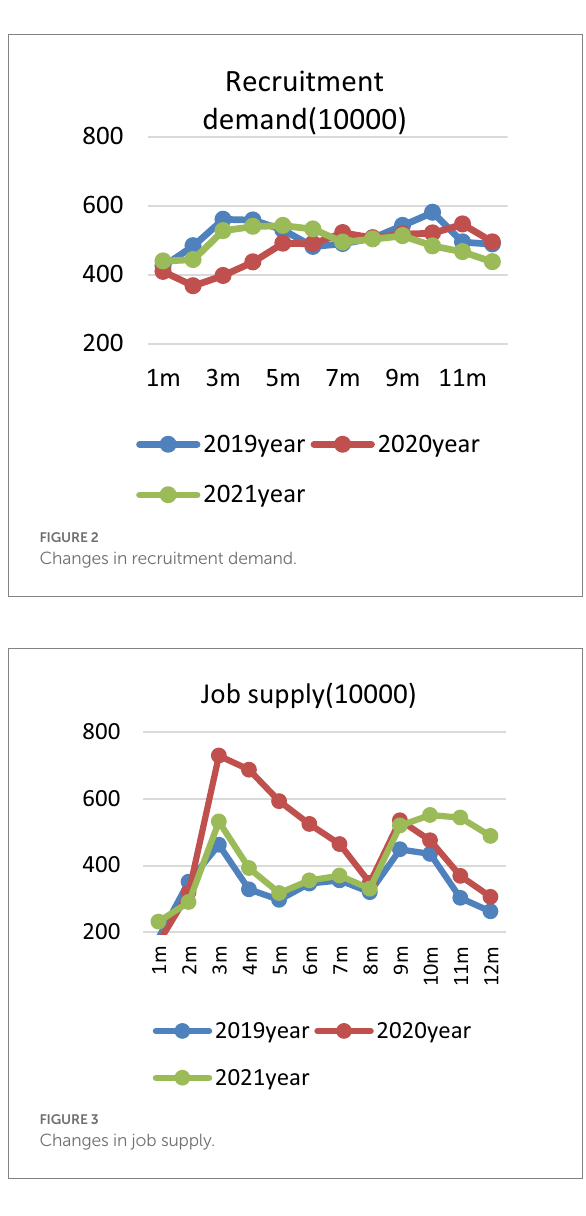
FIGURE 3 Changes in job